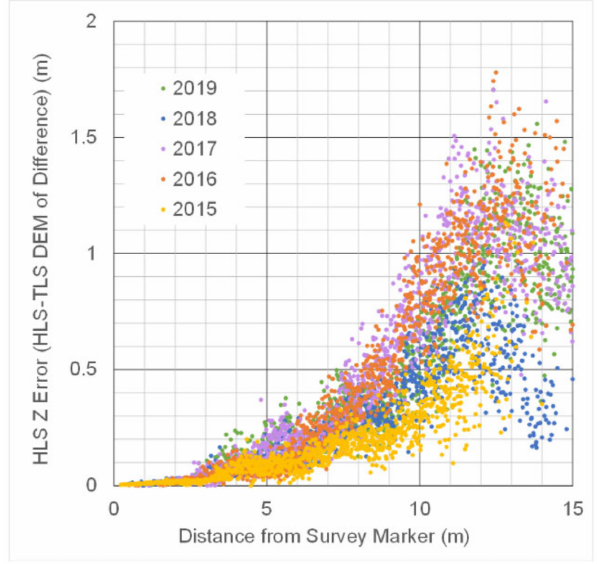
Figure 7. Relationship between average 0.1 m HLS DEM error (DoD of HLS to TLS) and distance from survey marker. Increasing errors at greater than 3 m distance from survey markers relate mostly to vegetation artefacts in the DEM near the scan